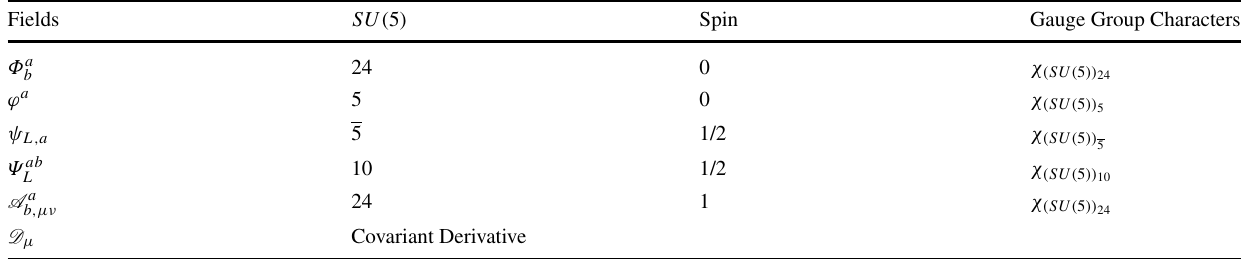
ters are the ones given in Eq. (109). Here, a , b are SU ( 5 ) indices and L denotes the chirality (i.e., left handedness of the field)